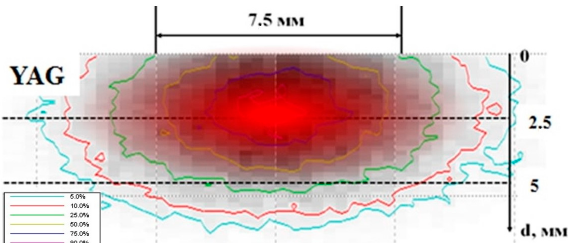
Figure 2. Distribution of the absorbed dose in the mixture during the passage of electrons with energy of 1.4 MeV.